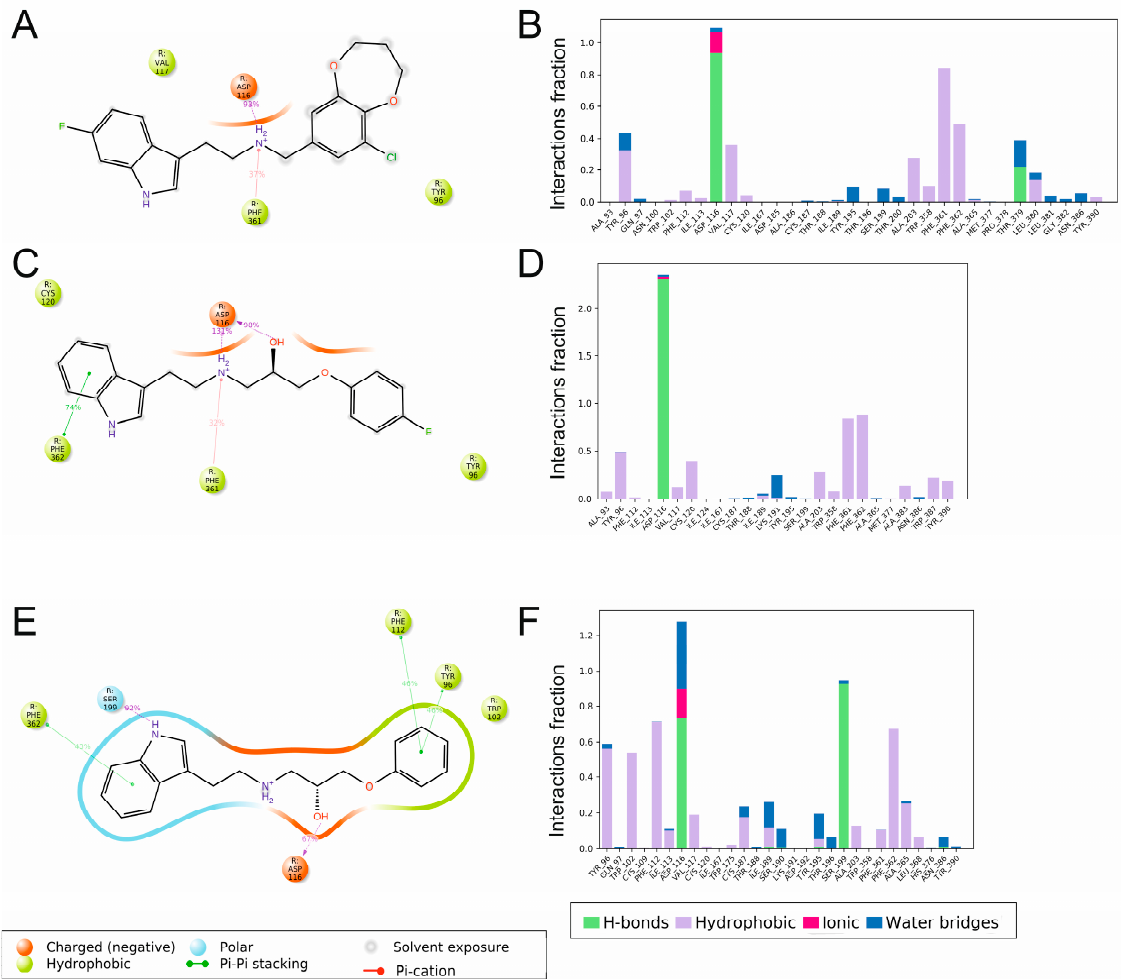
Figure 6. Ligand–receptor contacts ( A , C , E ) and histograms of ligand–receptor interactions ( B , D , F ) for serotonin 5-HT 1A receptor in complex with D2AAK5 ( A , B ), D2AAK6 ( C , D ), and D2AAK7 ( E , F ) dur- ing 1 µ s molecular dynamics simulations. The stacked bar charts are normalized over the course of the trajectory: for example, a value of 0.7 suggests that 70% of the simulation time the specific interaction is maintained. Values over 1.0 are possible as some protein residue may make multiple contacts of same subtype with the